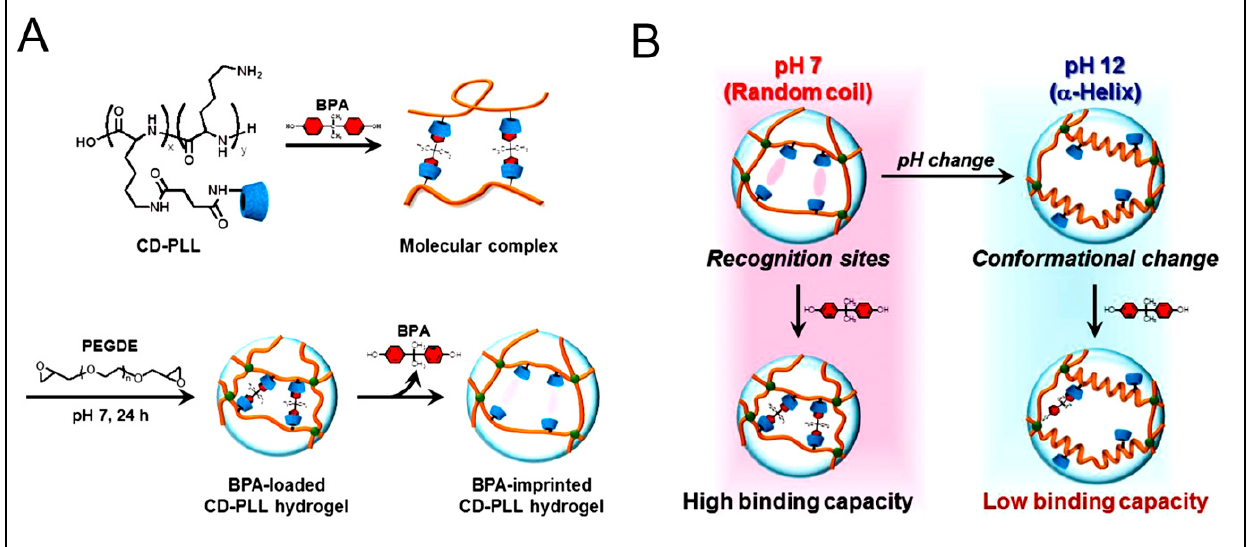
Figure 7. Schematic representation of ( A ) the preparation of the (Bisphenol A) BPA-imprinted β -cyclodextrin-poly(L-lysine) (CD-PLL) hydrogel by molecular imprinting. ( B ) BPA-responsive behavior of the BPA-imprinted CD-PLL hydrogel at neutral or basic pHs. Reprinted with permission from Ref. [193] , Copyright 2017, American Chemical Society.